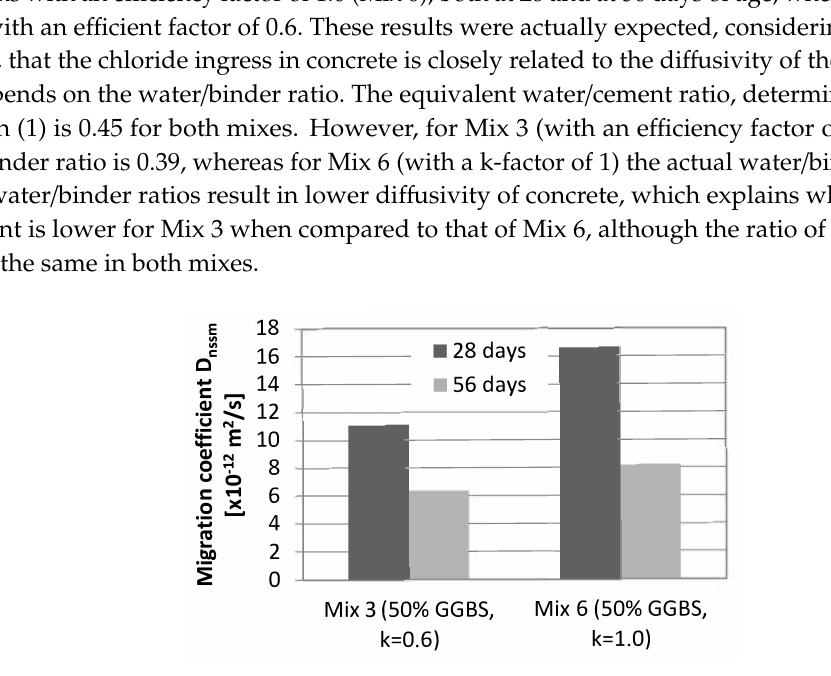
Figure 15. Rapid chloride migration coe ffi cient, DRCM, for mixes with 50% GGBS, 4.5% air content and di ff erent k-factor, cured at 20 ◦